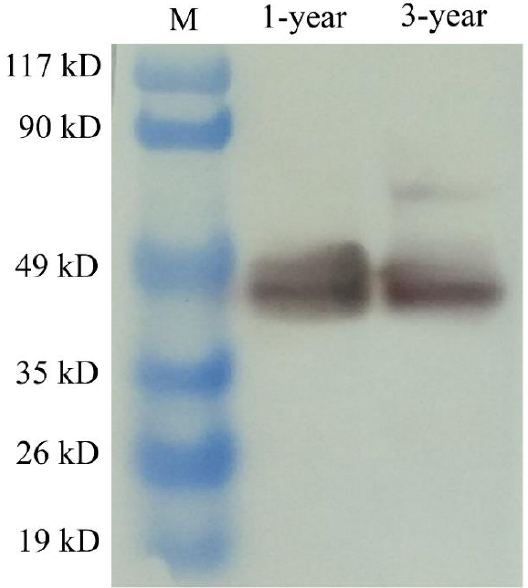
Figure 5. The Nanog protein examined in the turtle ovaries by Western blot. M: protein size markers; 1-year: protein sample from 1-year-old turtle ovary; 3-year: protein sample from 3-year-old